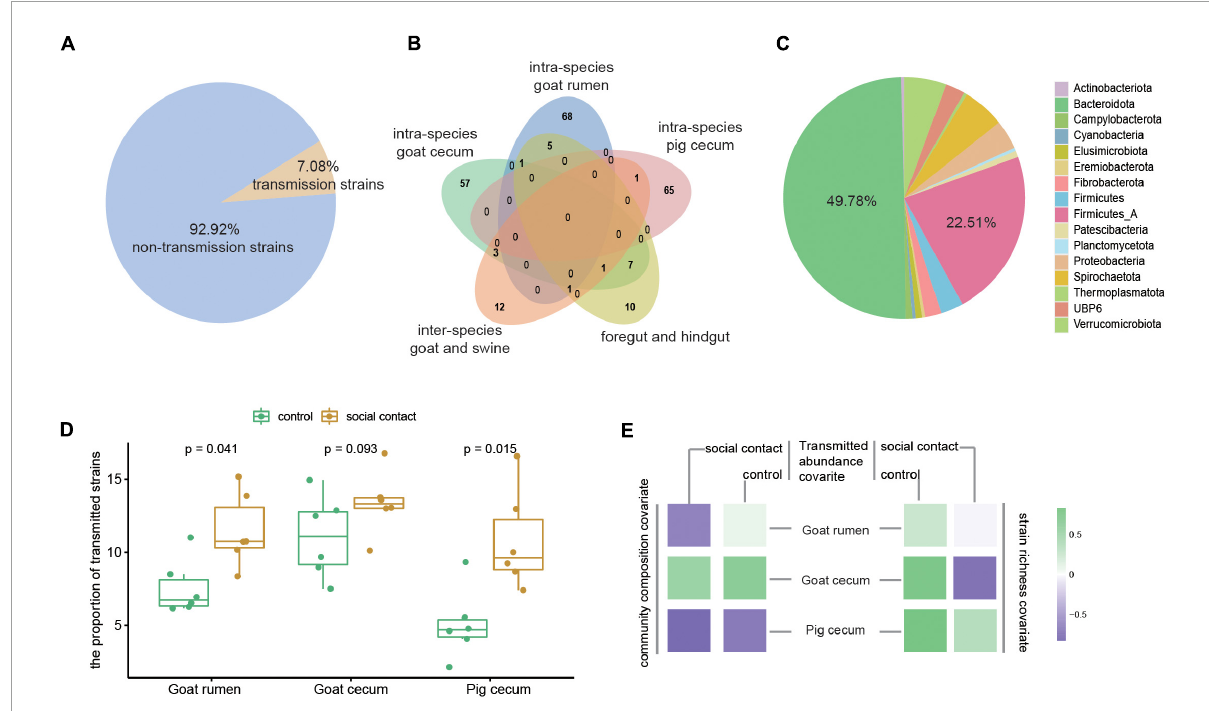
FIGURE3 Microbiome in different transmission events. (A) The transmission microbiota’s proportion of the total number of strains. (B) Overlap in the strains of the different transmission events (right). (C) The phylum annotation of the transmission microbiota proportion. (D) The proportion of transmission microbiota in total microbiome abundance in the control and social contact groups from goat rumen, goat cecum, and pig cecum. The Wilcoxon rank-sum test was used to assess the differences. (E) Tests for the relationship between the abundance of transmission strains in the control or social contact groups (goat rumen, goat cecum, and pig cecum) and stain richness ( ρ Spearman ) and community composition ( ρ Spearman